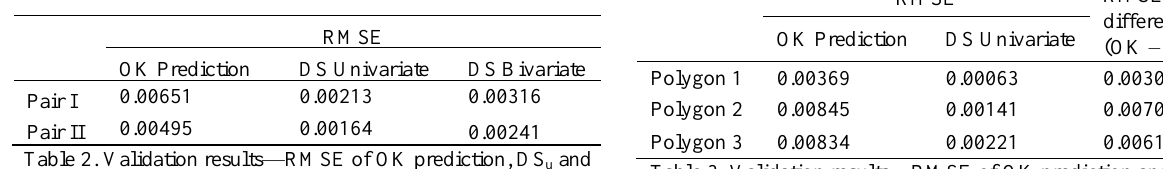
Figure 5. Histograms of residuals of all three cases (from left to right)—OK, DS